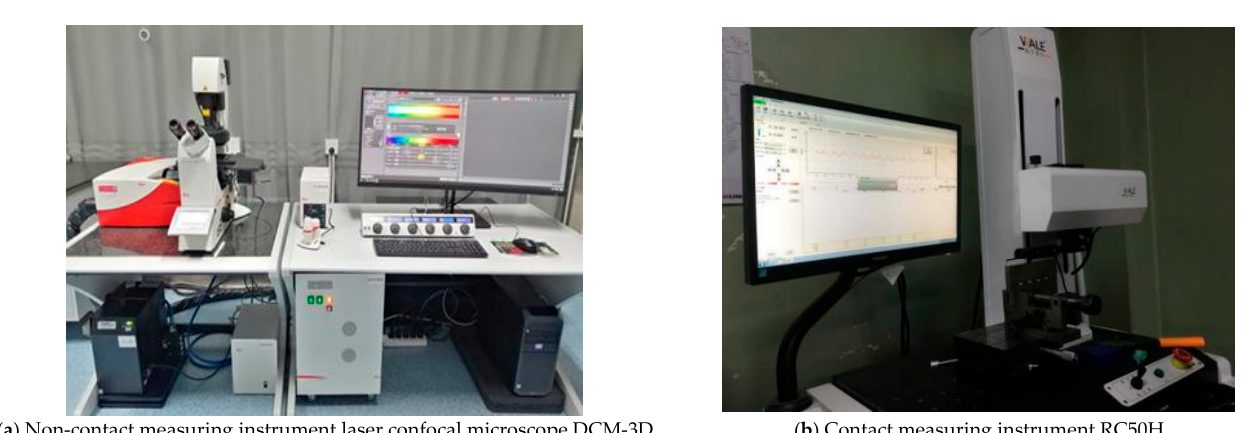
Figure 3. Surface roughness measuring equipment.